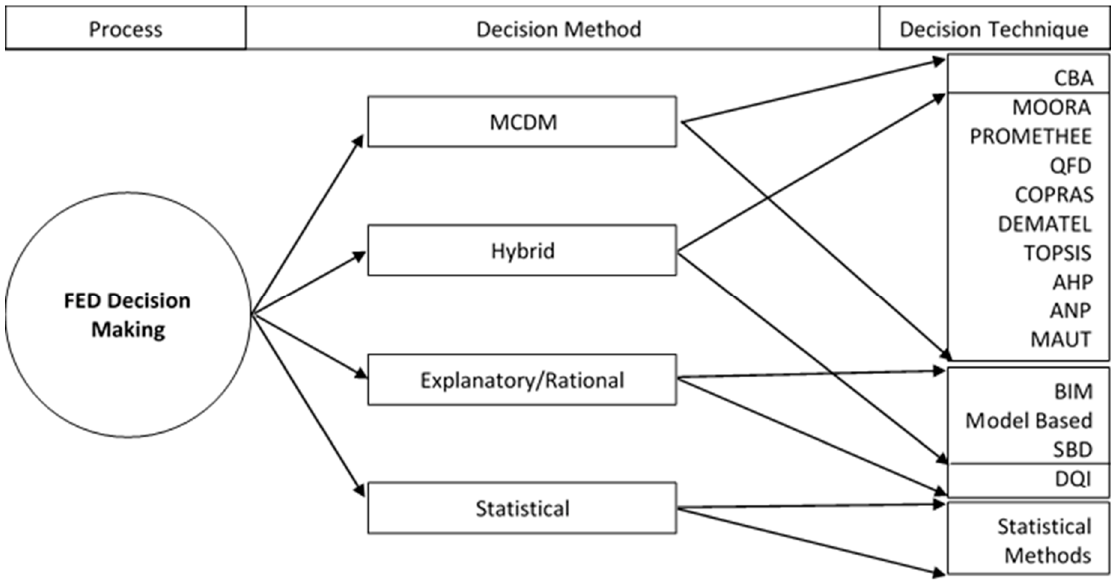
Figure 8. Relationships between design, decision methods and techniques.